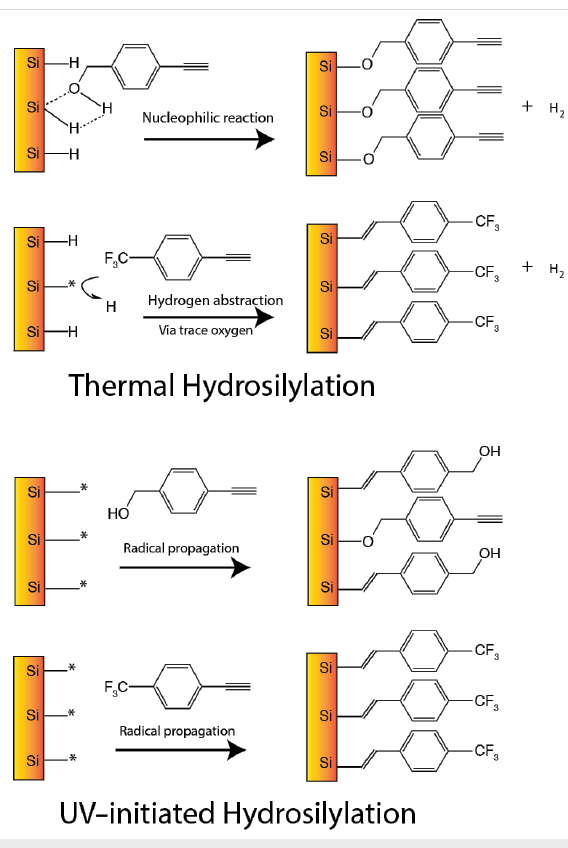
Figure 1: Hypothetical reaction pathways of ethynylbenzyl alcohol and trifluroalkyne during thermal and UV-initiated hydrosilyation.